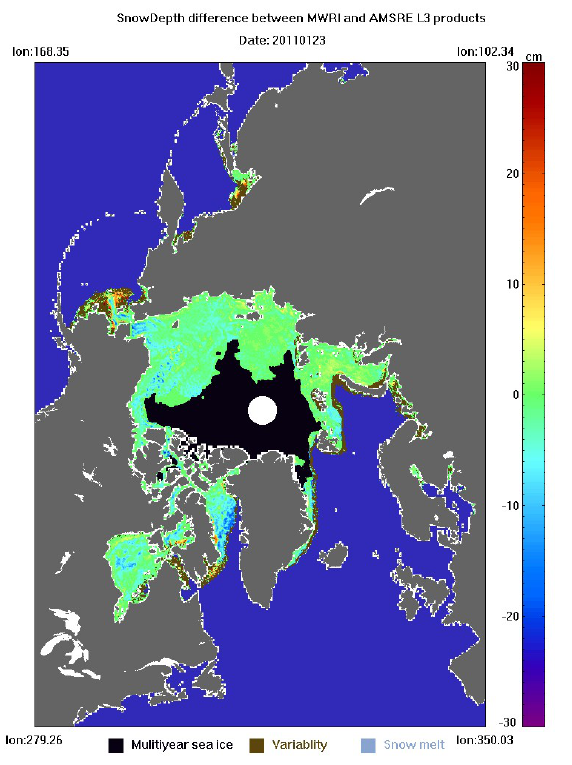
Figure 4. The snow depth of AMSR-E Level 3 Figure 5. MWRI minus AMSR-E Level 3 on January 23, 2011 on January 23, 2011 In order to display the statistics of the differences, the discrepancies between this study and the AMSR-E Level 3 products for each month are provided in Table 6. it demonstrates that the snow depth from this study is generally lower than the AMSR-E Level 3 products in the Arctic. The biases of the differences are ranged between -1.09 and -0.32 cm ， while the standard deviations and the correlation coefficients are from 2.47 to 2.88 cm and from 0.78 to 0.90, respectively. The differences are basically consistent in different months.